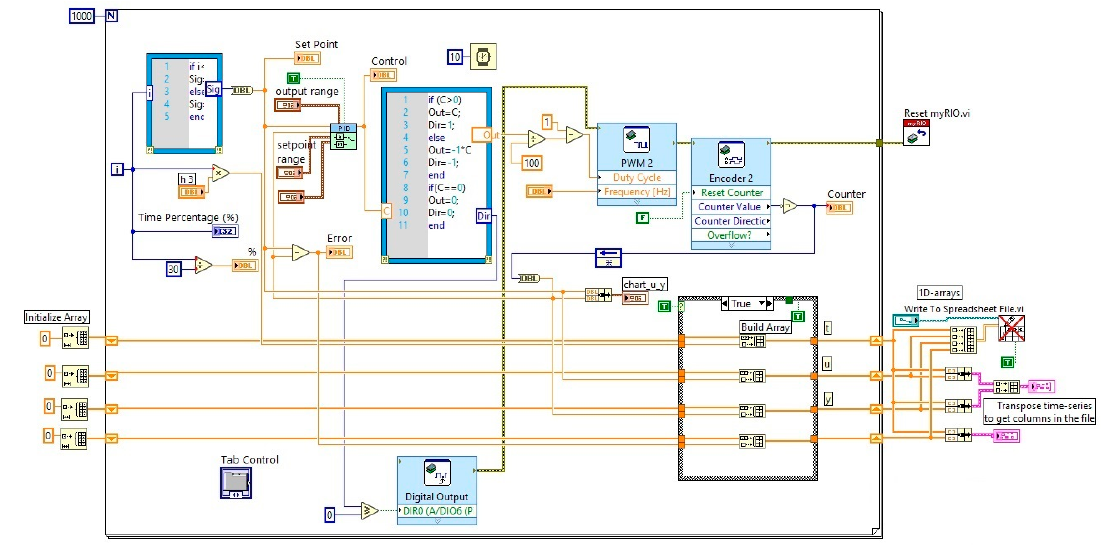
Figure 8. Program of motor control system.